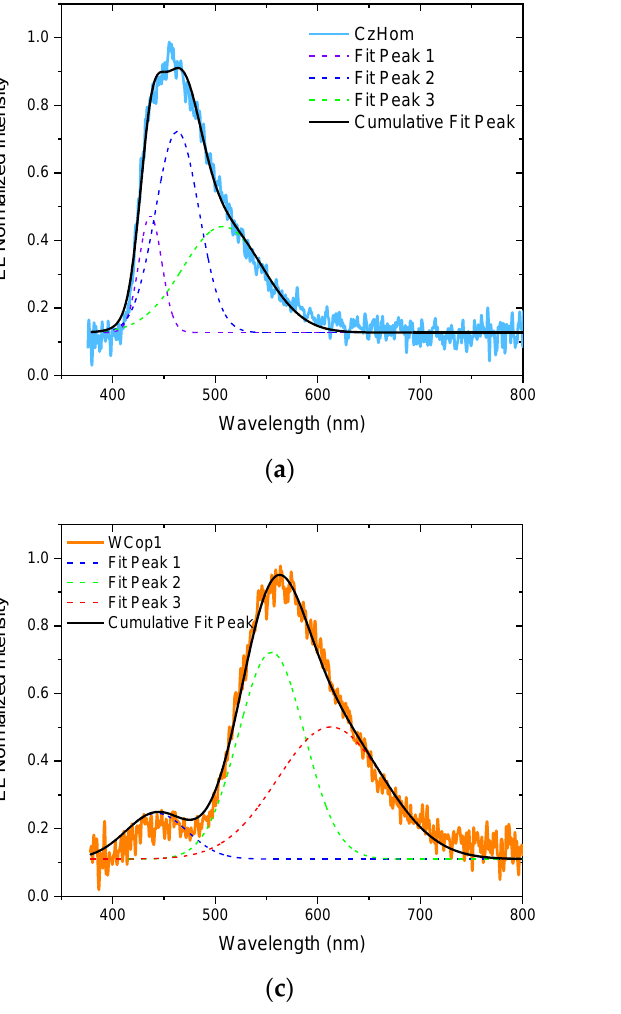
Figure 7. Deconvoluted normalized EL curves of ( a ) CzHom, ( b ) CzCop, ( c ) WCop1 and ( d ) WCop2 copolymers films.